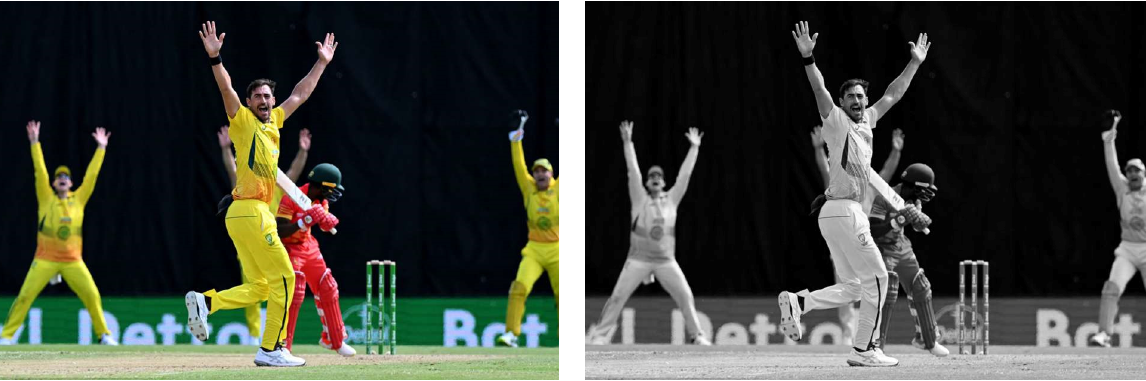
Figure 4. Conversion of color frame to gray scale.